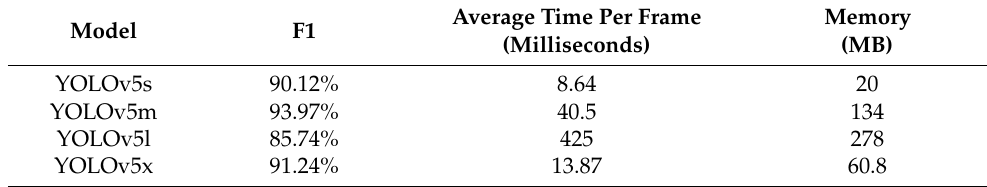
Table 4. Test results of the four